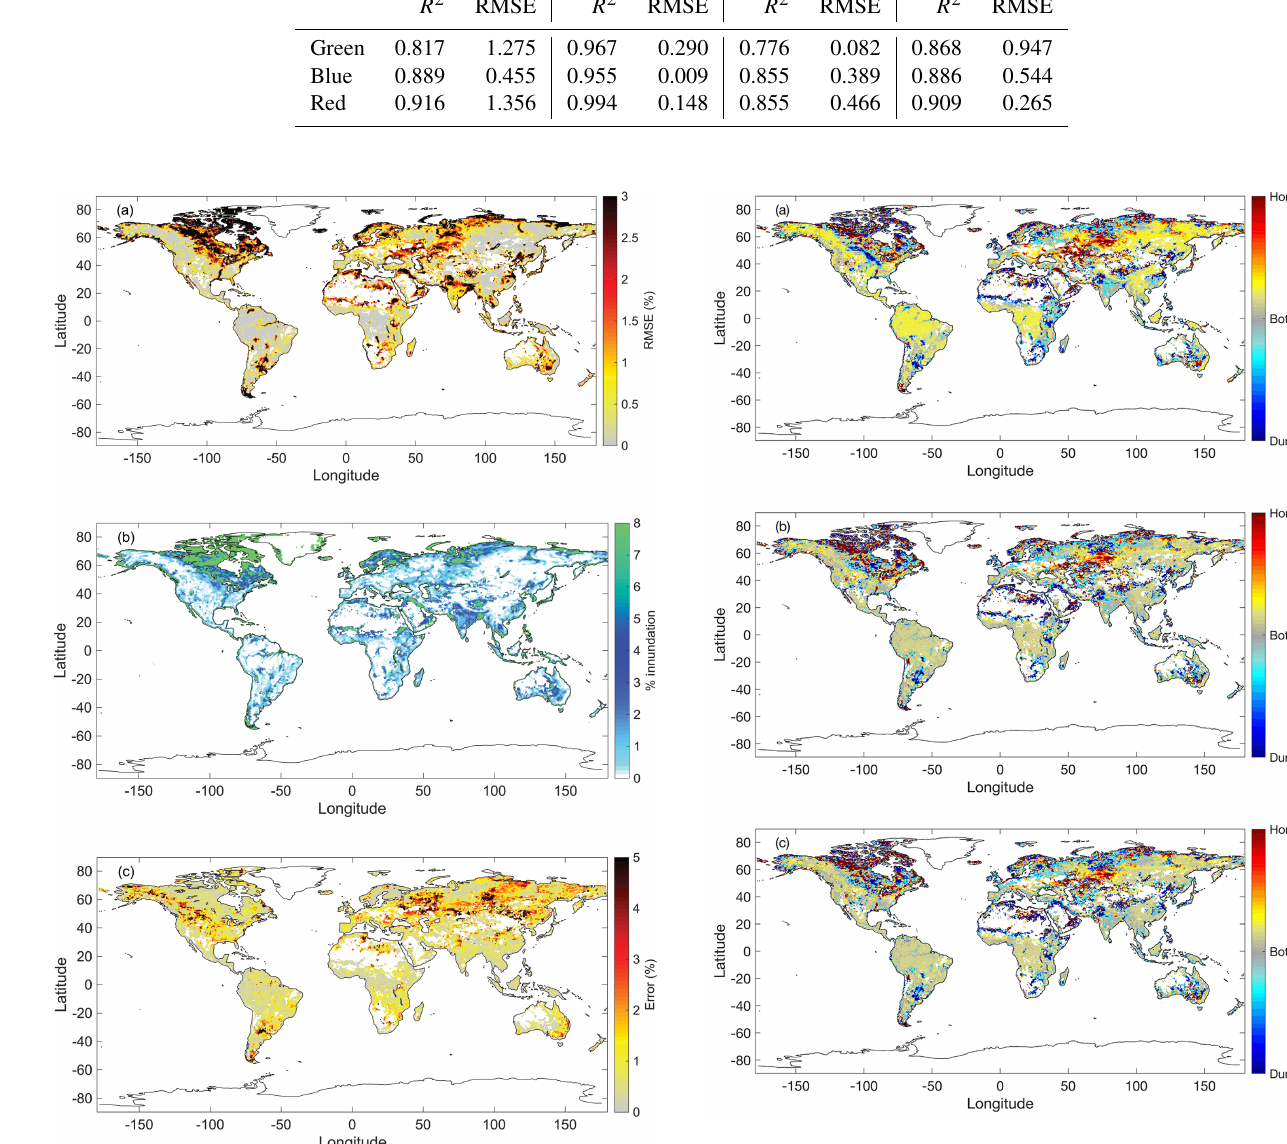
Figure 9. Control variable maps (a) without a time lag correction, (b) with a time lag correction of 0 to 5 months, and (c) with a time lag correction of 0 to 11